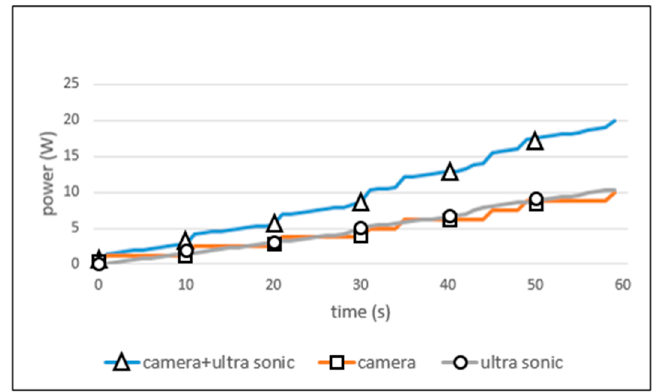
Figure 14. Power consumption on 2 sensors.